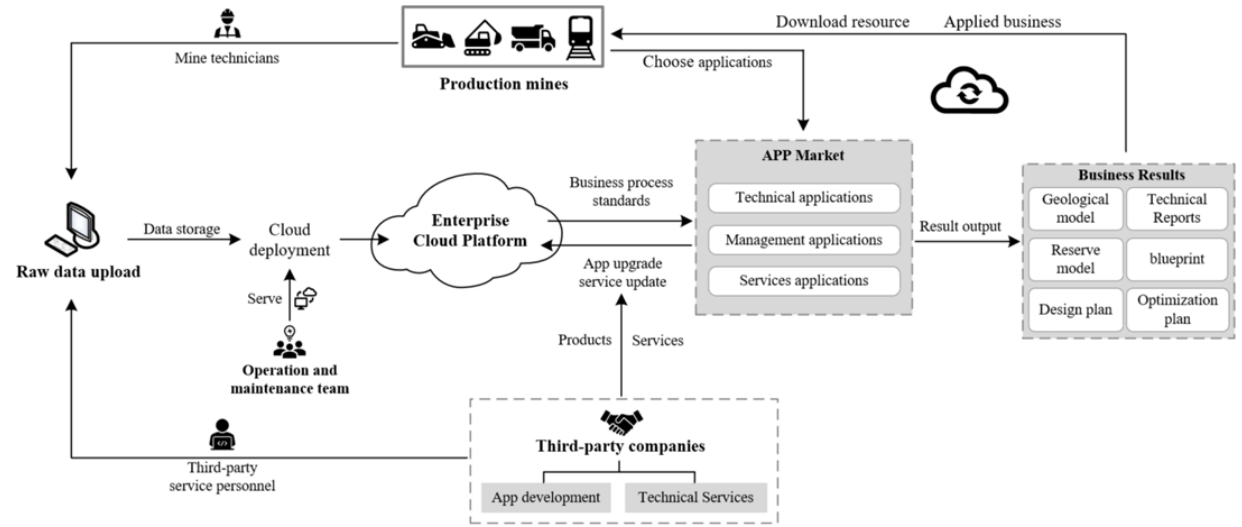
Figure 5. A mine production and operation management scenario under CM mode.